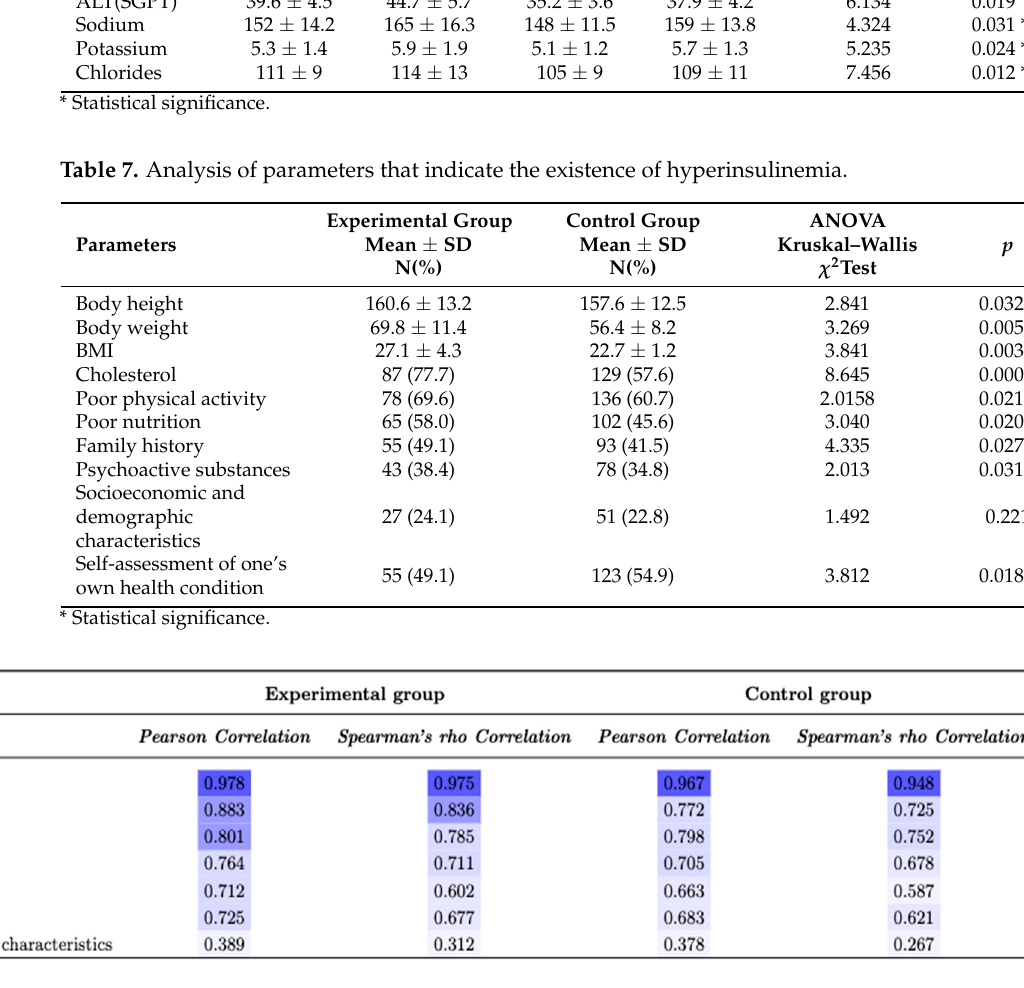
Figure 4. Correlation coefficients between the risk factors. Table 6. Values of hematological and biochemical parameters measured in both groups.